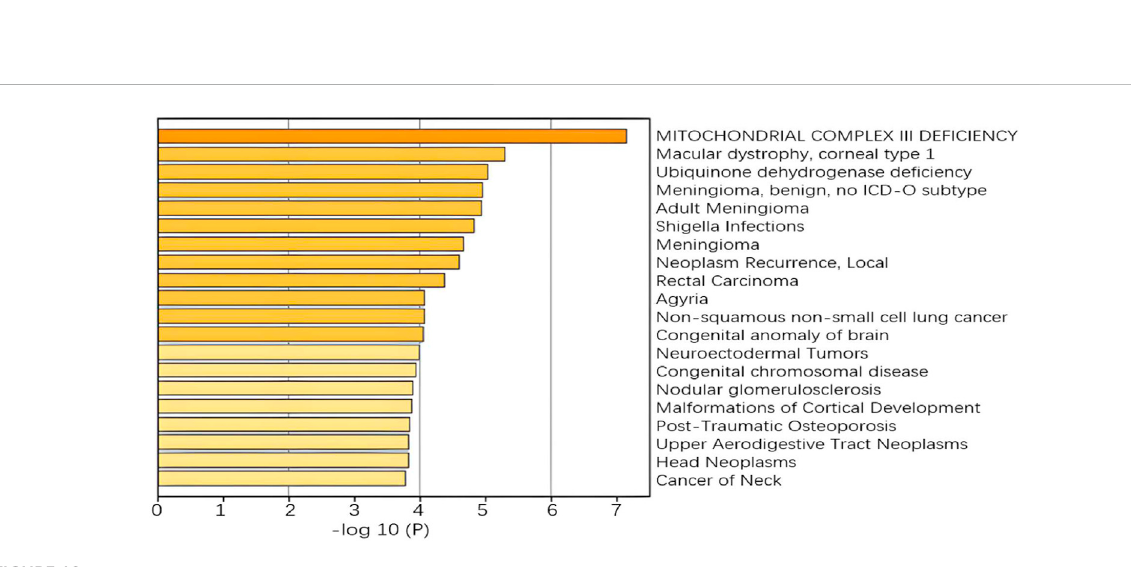
FIGURE 10 Enrichment analysis in